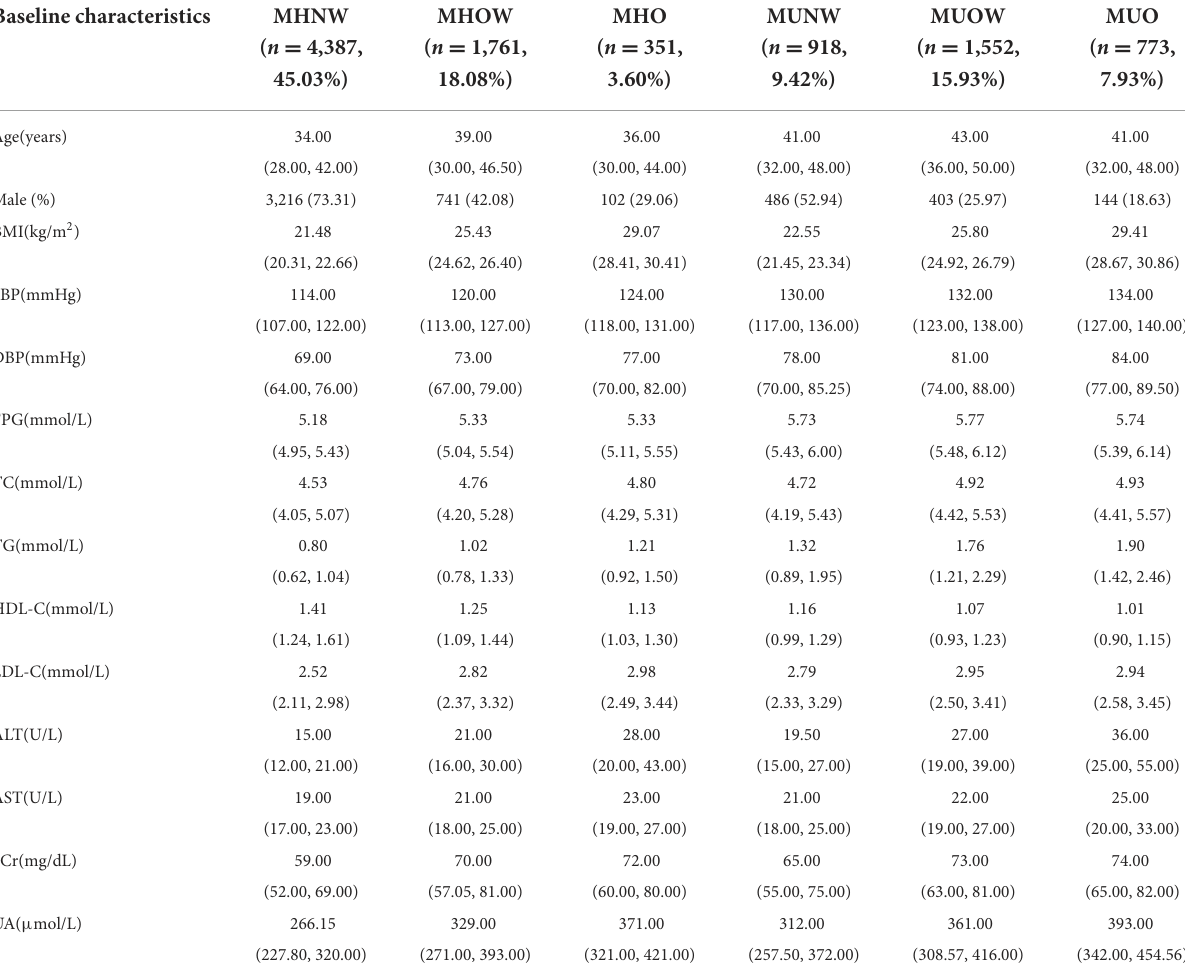
TABLE 2 The characteristics of each metabolism-weight phenotype at baseline.